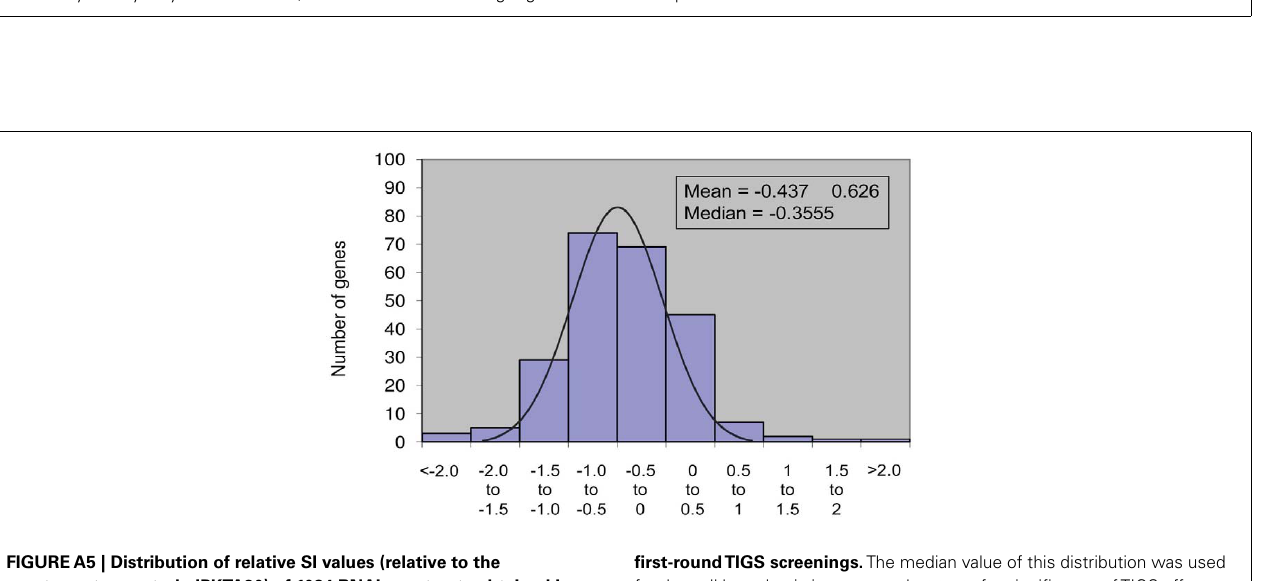
FIGUREA4 | Graphical SNP- and haplotype tables of genes significantly associated with resistance to Bgh . Amino-acid changes caused by non-synonymous SNP or in/dels located within coding regions